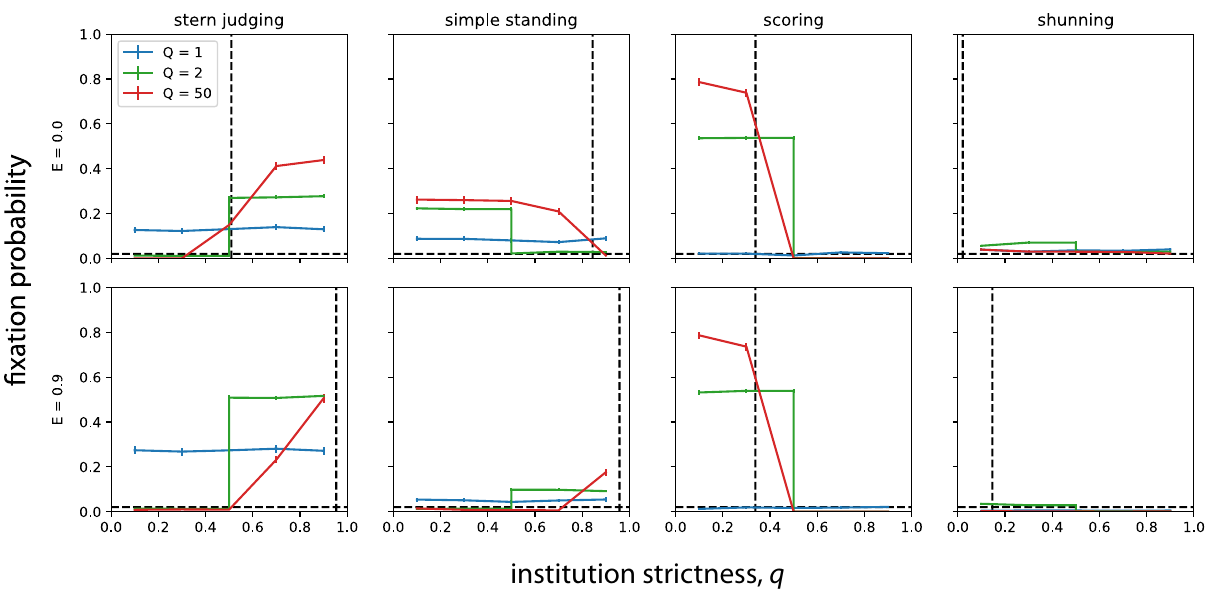
Fig. 4 The evolution of adherence to a public institution of moral assessment. We introduce a single institutional adherent (DISC-ADHERE) into a population consisting of non-adherents (DISC-PRIVATE), and we record the proportion of Monte Carlo simulations in which the institutional adherent eventually fi xes in the population. Fixation probabilities exceeding 1/ N indicate that adherence to the institution is favored by selection, compared to neutral drift. Vertical dotted lines represent mean frequencies of “ good'' reputations in the population at the time of adherent introduction, averaged over all subjective perspectives. Horizontal dotted lines indicate the neutral fi xation probability, 1/ N . Error bars indicate 95% con fi dence intervals for the binomial fi xation probability measured across 2500 replicate Monte Carlo simulations with population size N = 50, error rates e comprised of an external board of Q members (see Methods Section “ Competition between institutional adherents and non-adherents ” , and also Supplementary Fig. 7 for analogous results with an internal